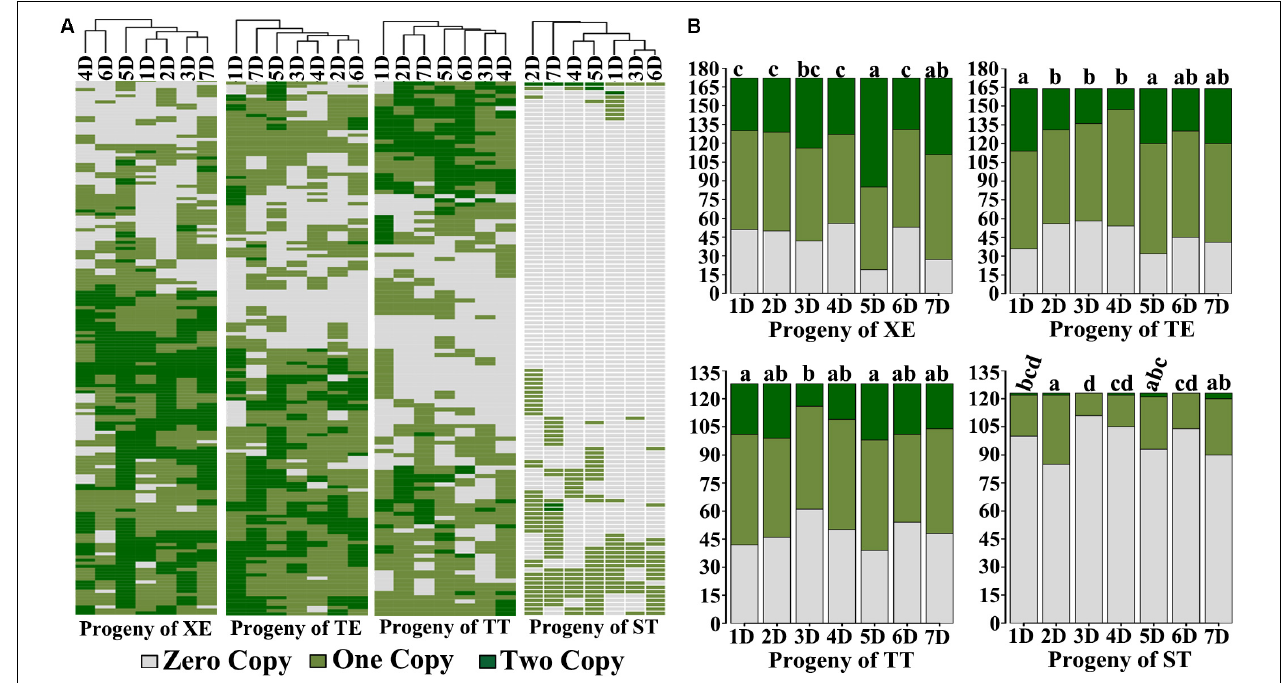
FIGURE 2 | Exact D-subgenome chromosome composition in the immediate progeny swarms of the four pentaploid wheat lines. (A) Heatmaps illustrating the D chromosome composition in each karyotyped cohort of the immediate selfed progeny swarms of the four pentaploid wheat lines. (B) Bar-plots showing the summarized copy number for each of the seven D chromosomes (1D–7D) in the immediate selfed progeny swarms of the four pentaploid wheat lines. The small letter(s) above each bar plot denotes for statistical difference of pairwise comparisons (Prop.test, P -values < 0.05). The y-axis in both (A,B) represents the number of karyotyped cohorts, while the x-axis is the seven D